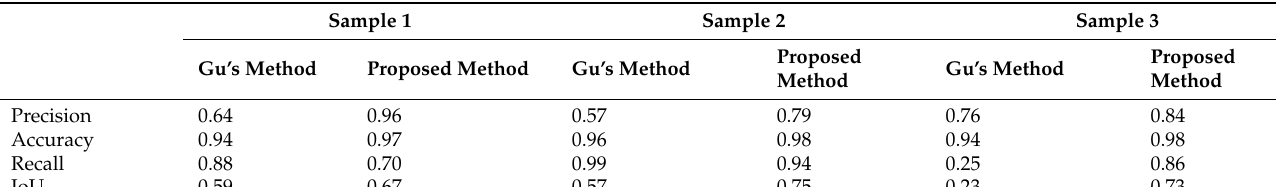
Table 3. Performance of local road extraction by Gu’s method and the proposed method.